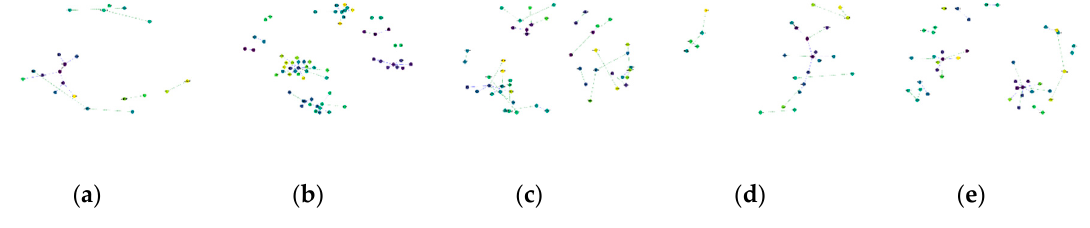
Figure 13. Di ff erent graphs generated on voxel categories. ( a ) Connected Elements (CEL) graph, ( b ) PE graph, ( c ) SE graph, ( d ) TE graph, and ( e ) RE graph.